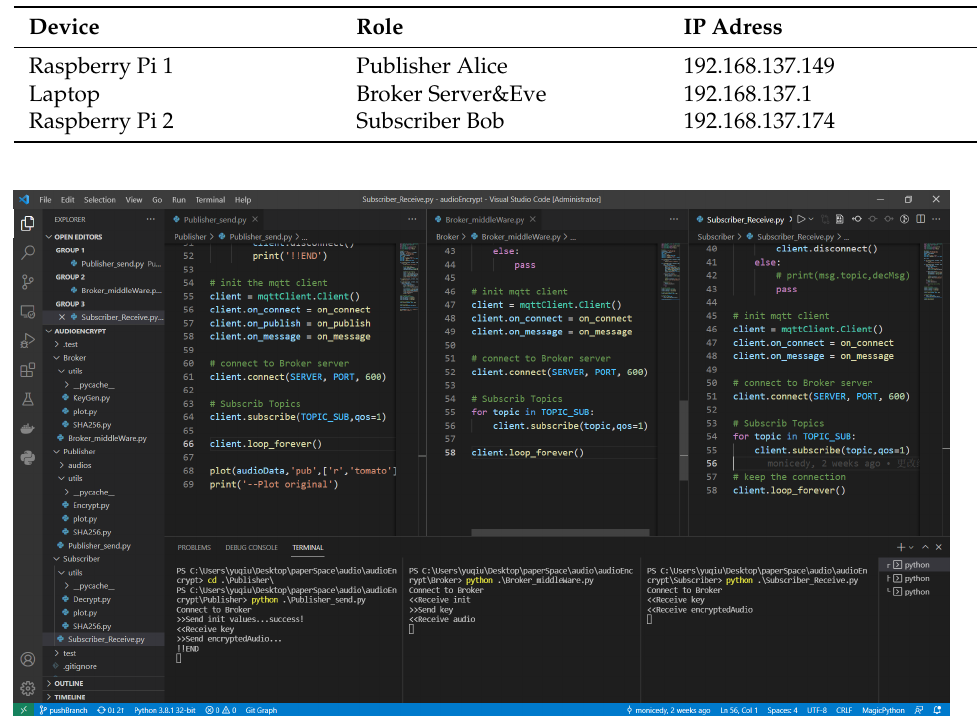
Figure 12. Code of Audio encryption by MQTT, left part is Publisher, middle part is Broker, right part is